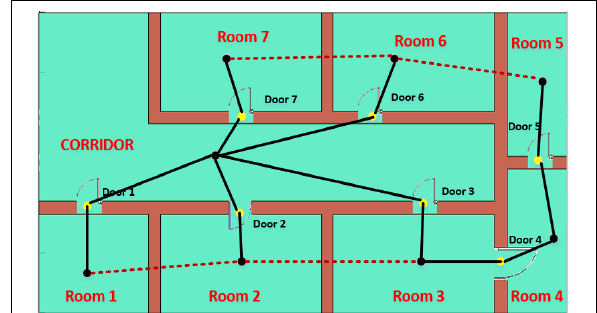
Figure 4. Dual graph representing the connectivity relations (black solid lines) and adjacency relations (red dashed lines) reconstructed for the first floor of the synthetic point cloud.